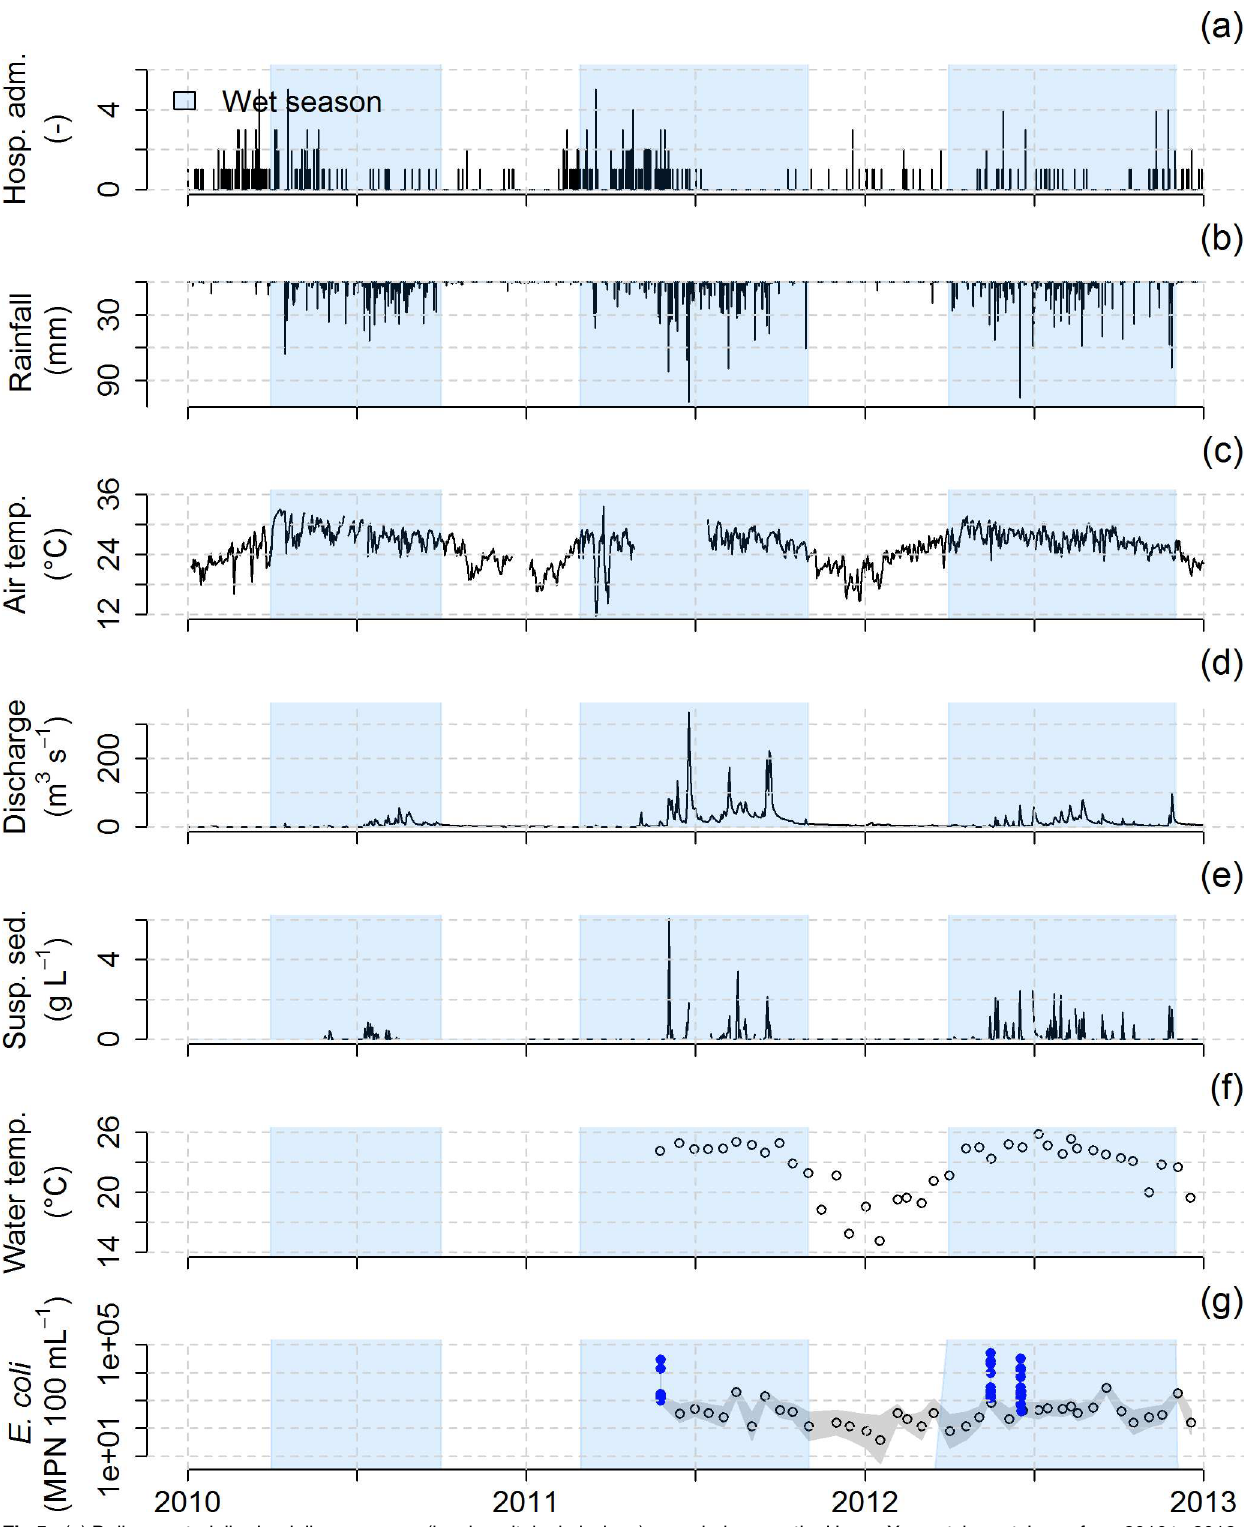
Fig 5. (a) Daily reporteddiarrhealdiseasecases (i.e., hospitaladmissions)recordedacross the HouayXon catchment, Laos, from 2010to 2012, (b) Daily rainfall (mm) recordedat the Houay Pano meteorological station, (c) Daily air temperature (˚C) recorded at the Houay Pano meteorological station, (d) Daily discharge(L s -1 ) recordedat the S4 samplingstation, (e) Daily record of suspendedsediments (g L -1 ) at S4,